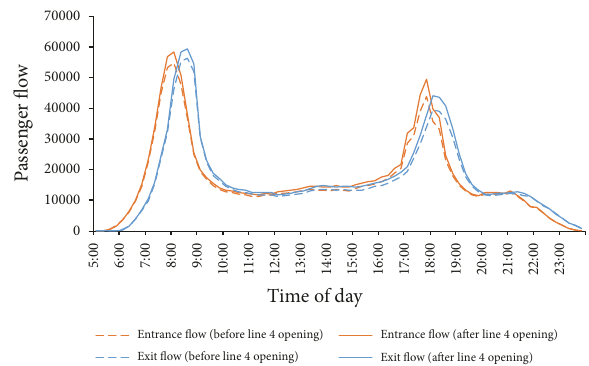
Figure 3: 15 min metro passenger flow distribution before and after Line 4